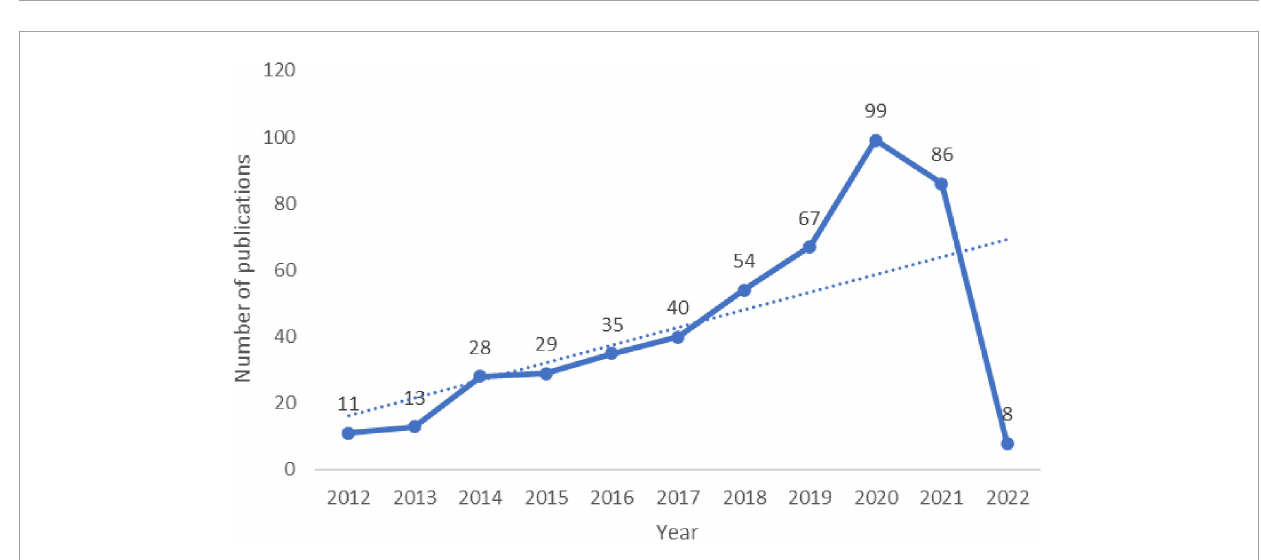
FIGURE2 Annual publication outputs and the model fitting curve of time trend of relevant publications.